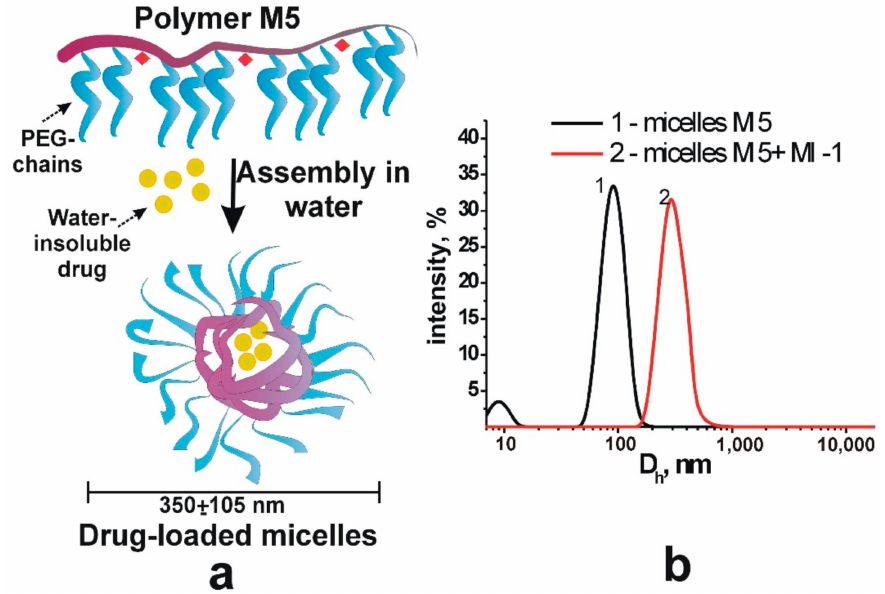
Figure 2. Scheme ( a ) of the formation of stable micellar structures filled with drugs and ( b ) hydrody- namic diameter of polymer micelles M5 and drug-filled micellar structures (M5 +